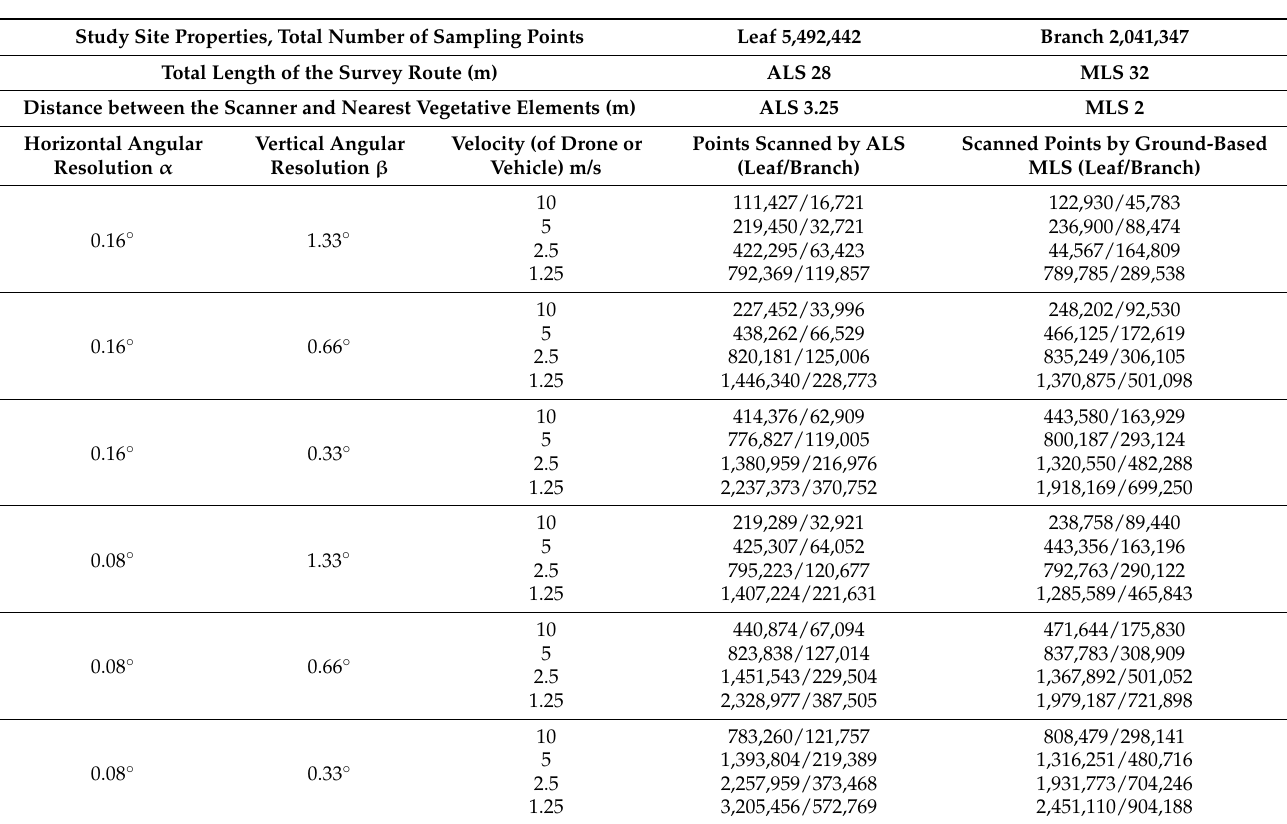
Table 3. The results of ALS and ground-based MLS versus the variations in the tuning of the velocity of the drone or vehicle, the vertical angular resolution, and the horizontal angular resolution,